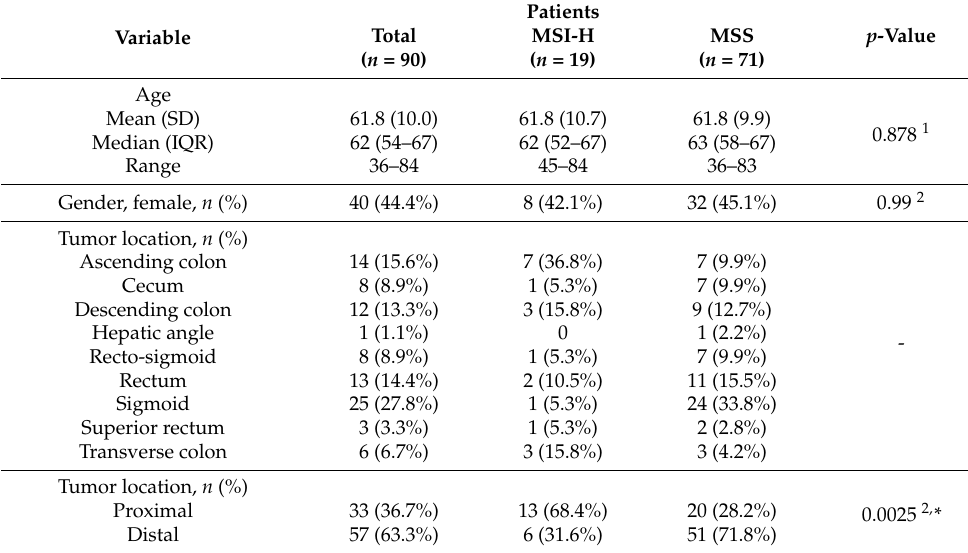
Table 1. Characteristics of the cohort used in this